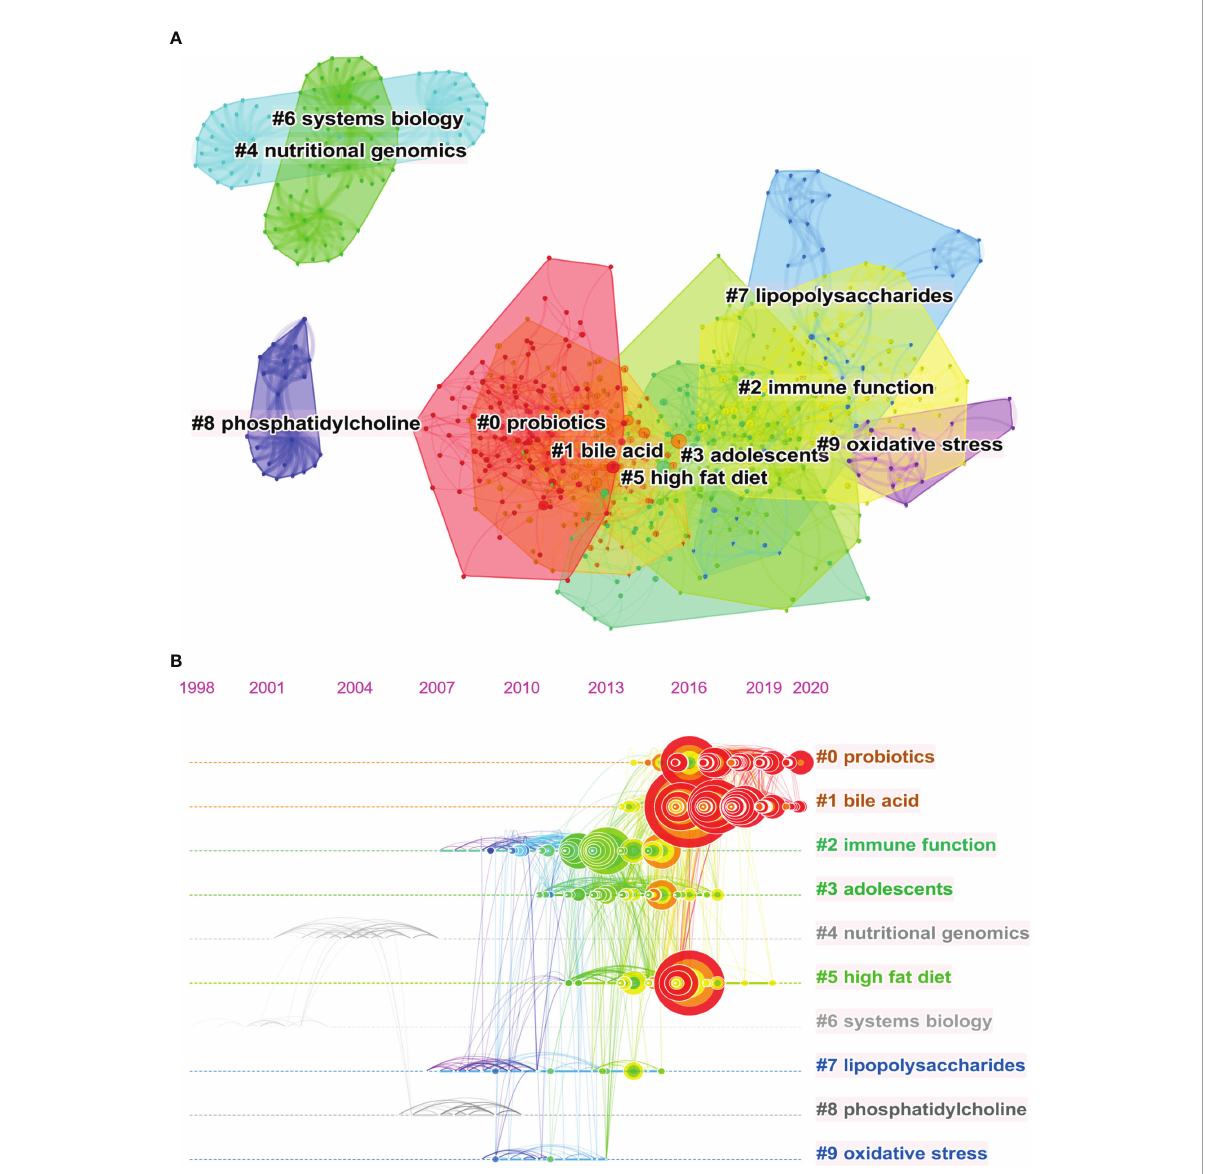
FIGURE 7 Analysis of Co-occurring Keywords of publications on the links between the gut microbiota and MAFLD between 2002 and 2021. (A) Clustered networks of co-citation status of the investigated reference and the 707 citing articles via CiteSpace. The top 10 largest clusters of citing articles on the links between gut microbiota and MAFLD research are shown. (B) A timeline view of the top 10 largest clusters of citing articles on the links between gut microbiota and MAFLD research. Right side = cluster